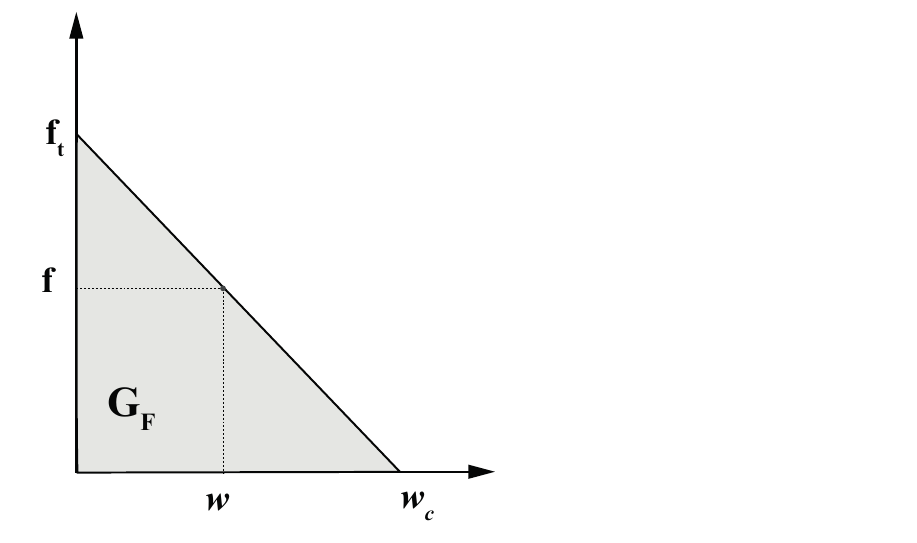
Figure 2. Scheme of a cohesive law, where f t is the tensile strength, w c is the critical opening displacement and the shade area, calculated through f t and w c , is G F